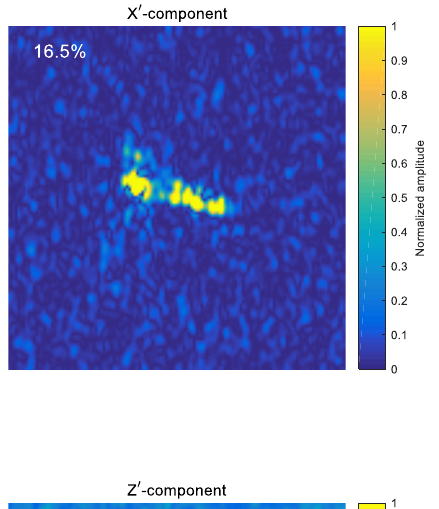
Figure 6, the three components projected to the rotated axes of X (cid:48) , Y (cid:48) , and Z (cid:48) show a concentration of signal powers on the Z (cid:48) -axis, as expected. The Z (cid:48) -component accounts for 74.8% of the total signal power, while the X (cid:48) - and Y (cid:48) -components account for only 16.5% and 8.8%, respectively.